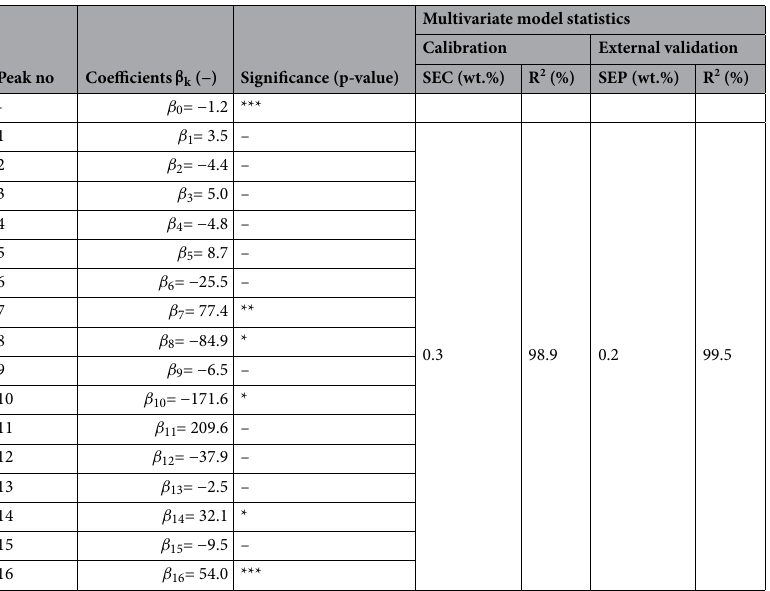
Table 3. Quality parameters for multivariate multiple regression. SEC standard error of calibration, SEP standard error of prediction, R 2 adjusted coefficient of determination. p-value: > 0.1, *< 0.05, **< 0.01, ***<